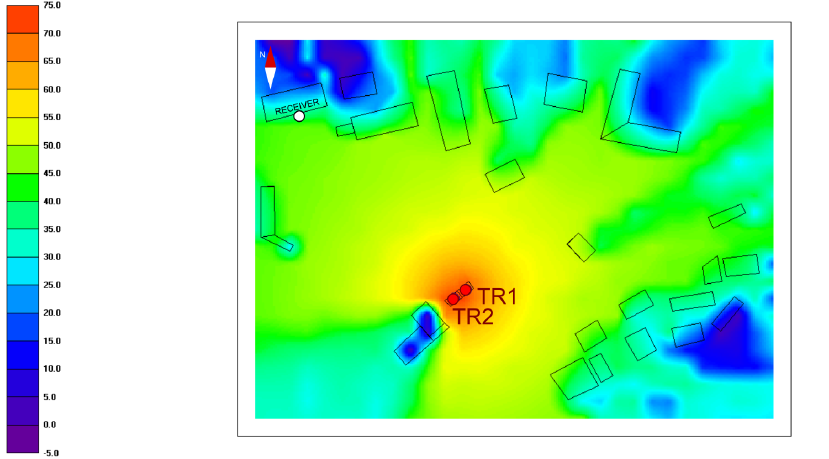
Figure 10. Overall A-weighted SPL distribution in the investigated area as obtained from simulation 4 m above the